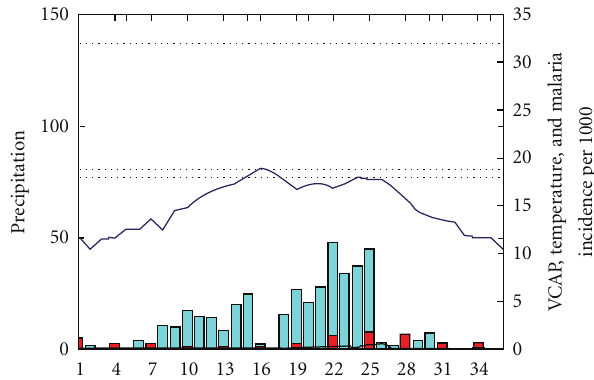
Figure 5: Region 2: the black line represents the VCAP values (low values), the blue bar represents rainfall (mm/dekad with values below 50mm), the blue line represents temperature (below 18 ◦ C), and the red bar represents malaria incidence per 1000 habitants.